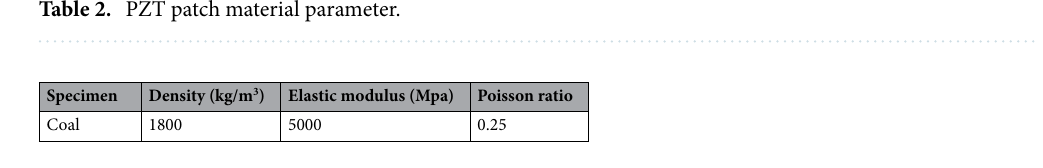
Table 3. Material parameters of